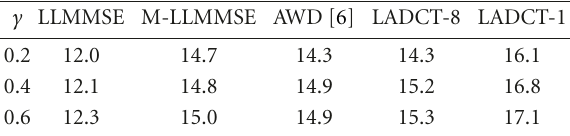
Table 4: SNR results for Lenna, degraded with film-grain type of noise at 2.9